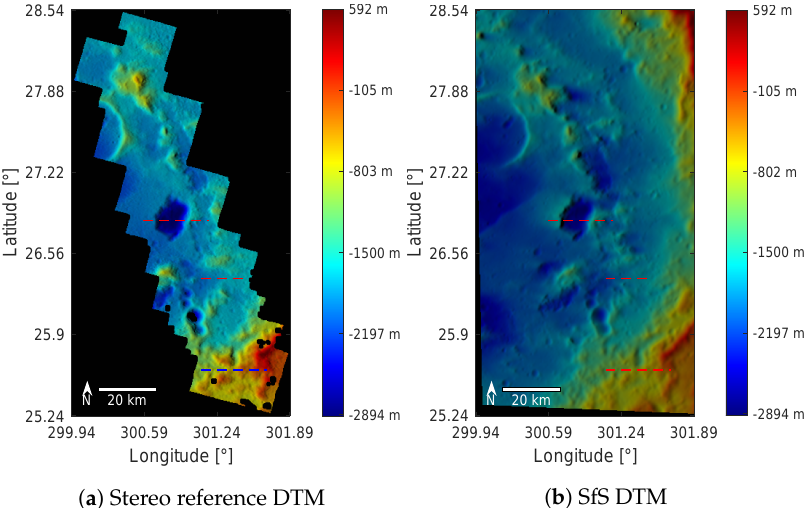
Figure 8. ( a ) The stereo DTM from Fassett [29] that is used for comparison with ( b ) the SfS DTM. The dashed red lines show the positions of the northern, central and southern profile that are examined in Figure